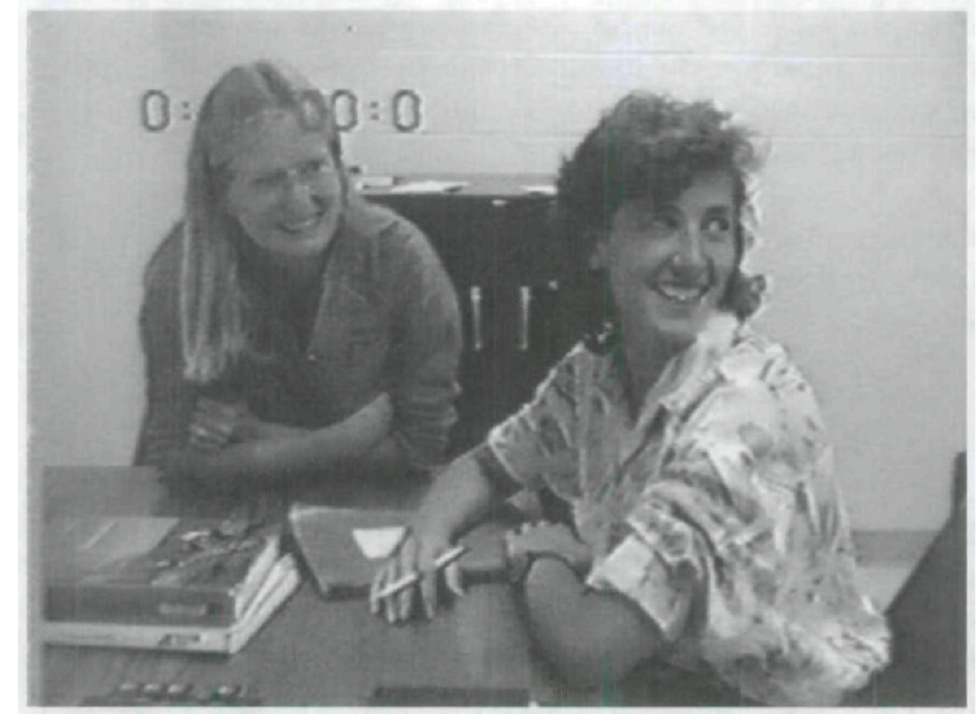
Figure 3. An interlocutor in body torque in Fox (1993), referred to by Schegloff (1998). People have countless ways to continue and extend sequences basically indefinitely.